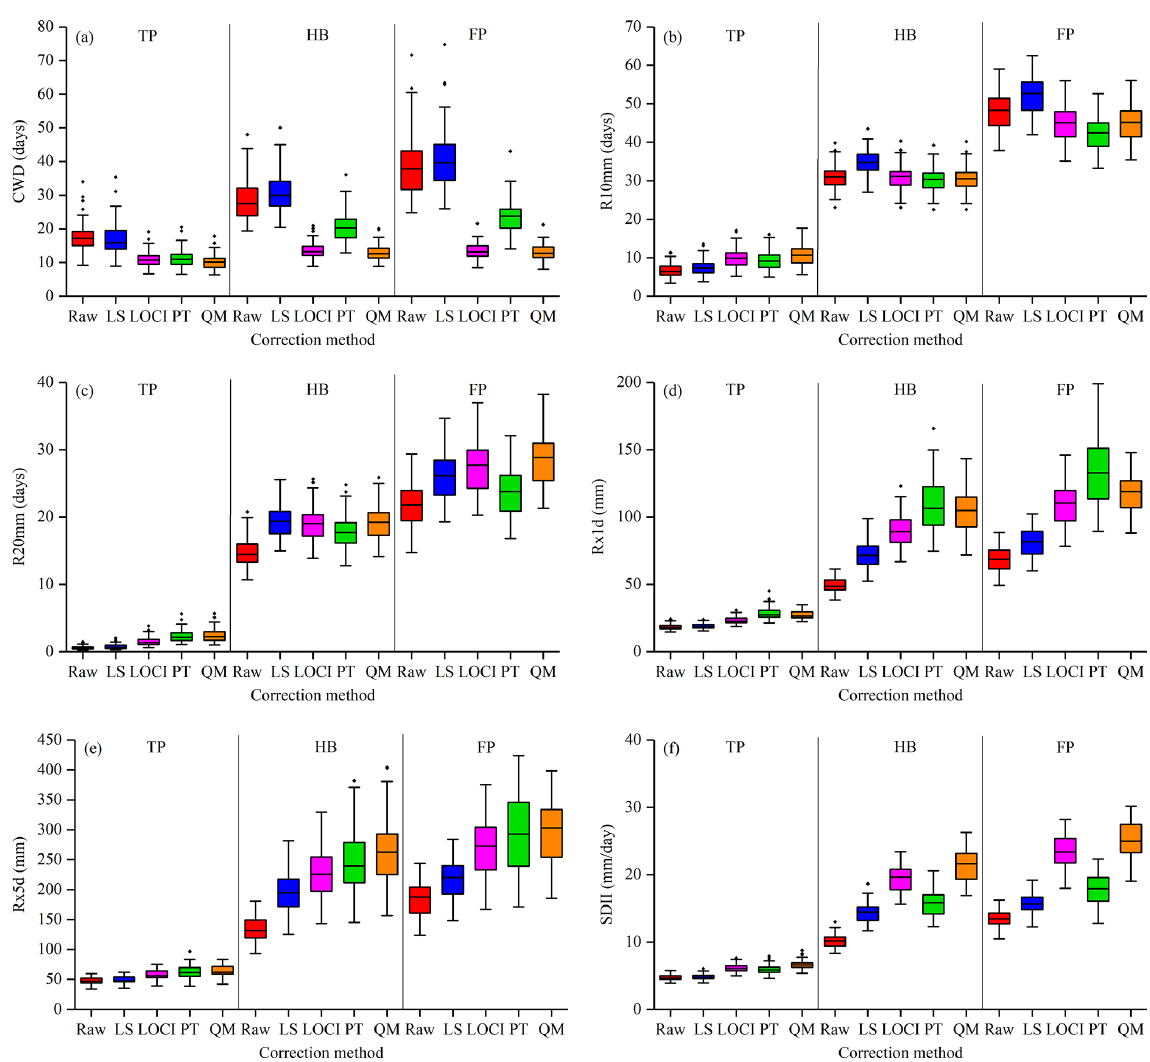
Figure 4. Box and whisker plot for (a) CWD, (b) R10mm, (c) R20mm, (d) Rx1d, (e) Rx5d, and (f) SDII during JJAS in the three different physiographic zones (the TP, HB, and FP) of the YBRB derived from the original and corrected APHRODITE